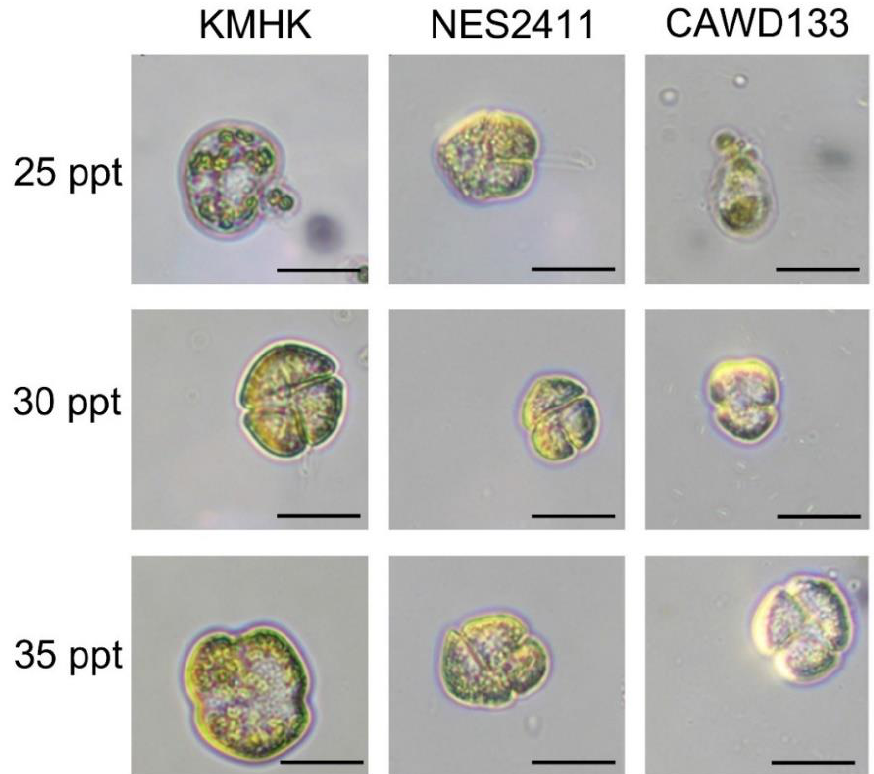
Figure 5. Microscopic images of three K. mikimotoi strains (left column: Hong Kong strain KMHK; middle column: Japanese strain NIES2411, and right column: New Zealand strain CAWD133) growing at log phase and three different salinities (25, 30 and 35 ppt). Cell lysis was observed in KMHK and CAWD133 growing in 25 ppt before the cells entered log phase. Corresponding diagrams were created before cell lysis occurred (i.e., day 3). Scale bar represents a width of 25 μm.